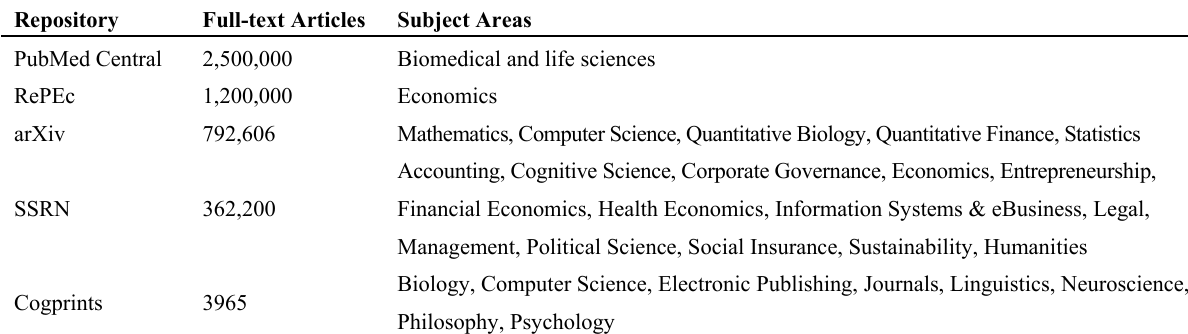
Table 2. Major subject repositories and their content size as of October